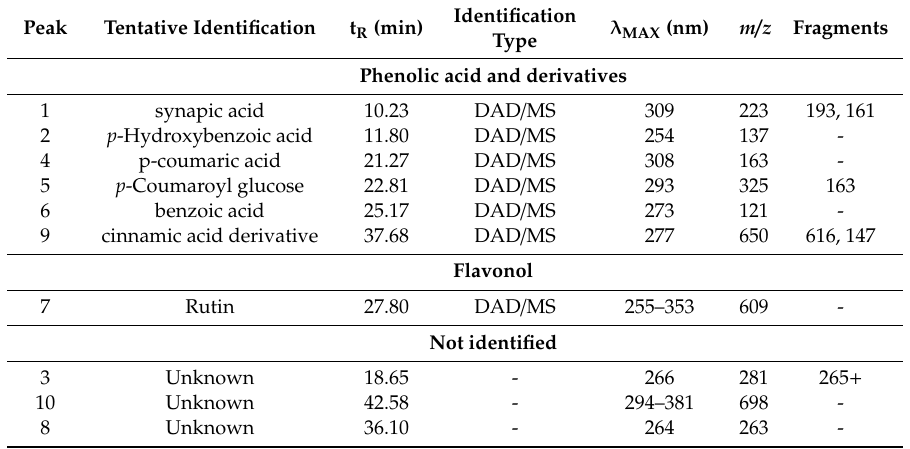
Table 5. Polyphenolic compounds detected in Z. lotus (EtOAc extract) by HPLC-DAD-ESI / MS. Peak